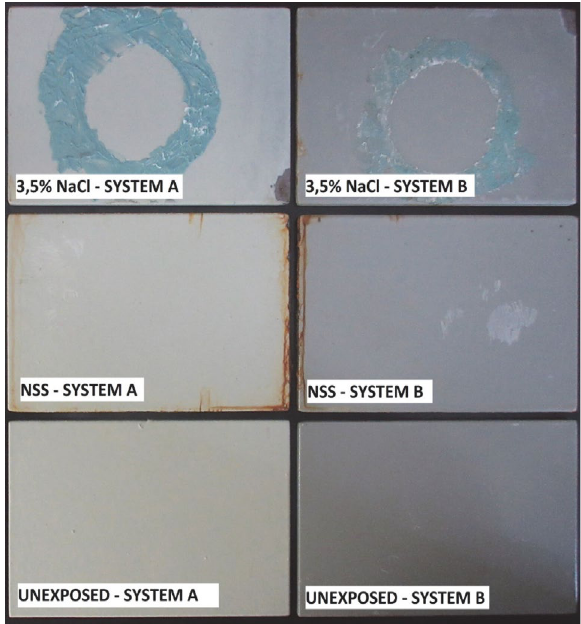
Figure 4. Low-frequency impedance read at 0.1 Hz as a function of exposure time for coating systems A and B during exposure to 3.5 % NaCl and NSS.